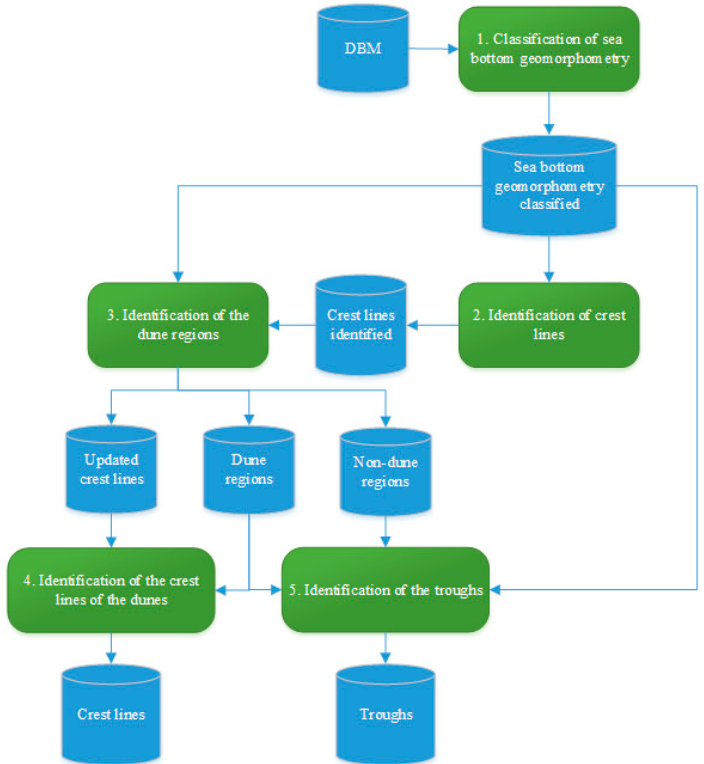
Figure 5. Phase I of the dune segmentation approach.